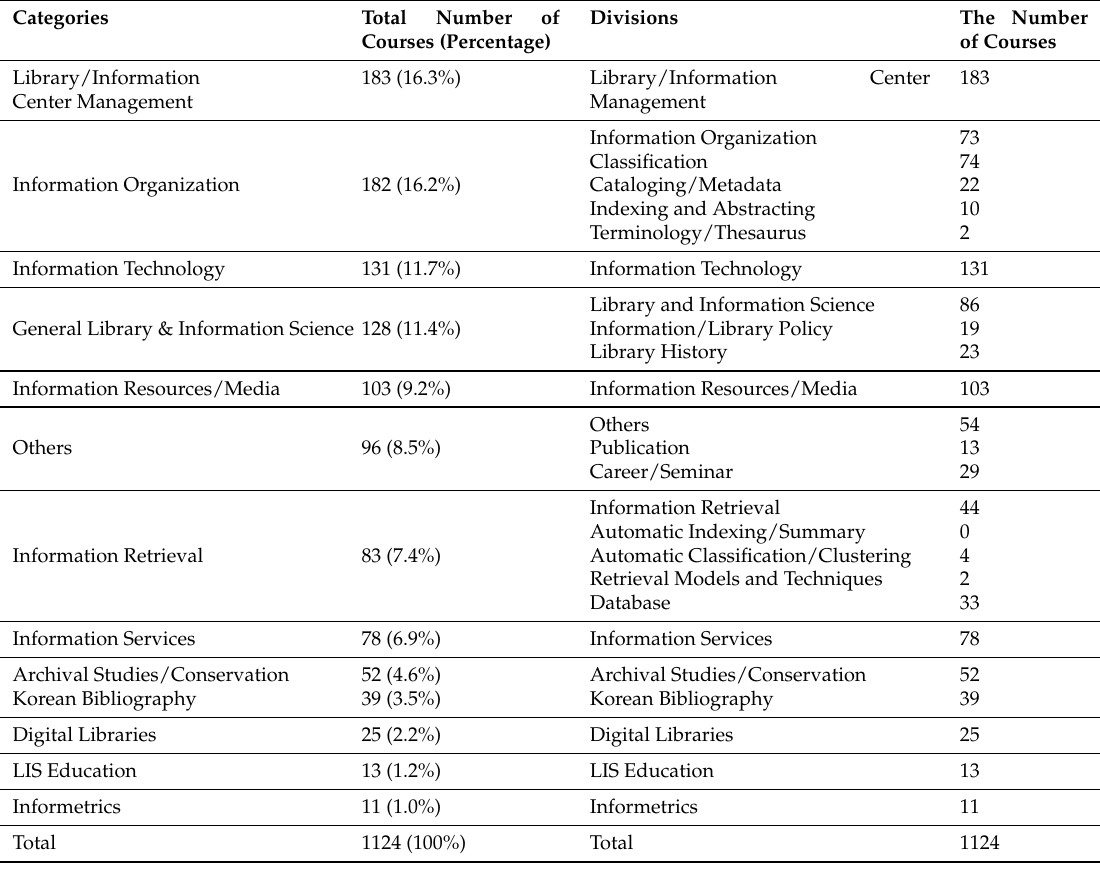
Table 1. Frequency of courses, based on the academic research